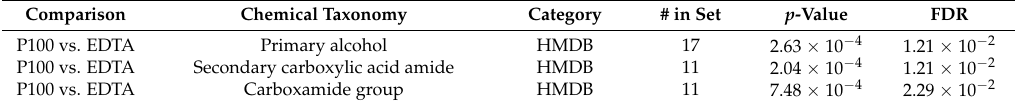
Table 3. Taxonomy enrichment results. Repeated measures ANOVA with Bonferroni FWER ≤ 0.05 and fold change ≥ 1.5 was used to identify differences between the P100, EDTA and SST. The EDTA and P100 control plasma tubes were at 0 h post-collection. The SST serum control tube was 30 min post-collection to allow clot formation. The significant metabolites from each comparison were exported to MBRole to determine whether certain chemical classes were more predominantly captured by specific tubes. The top 15 significant chemical taxonomy classes for each comparison, where applicable, is listed numerically (# in set) based on total number of compounds in each class and FDR ≤ 0.05. The complete list is available in Supplemental Document S1 (Supplementary